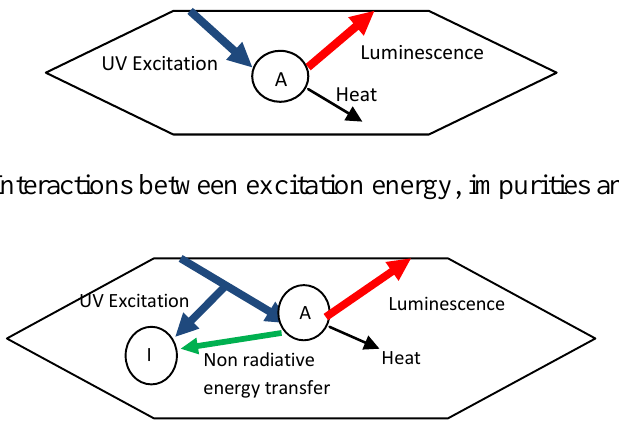
Figure 24. UV Excitation energy acting directly on the activator.